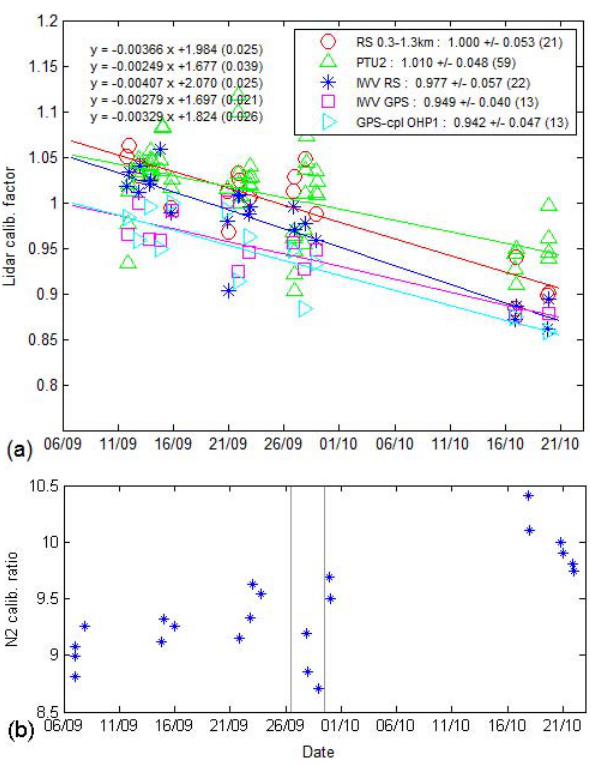
Fig. 4. Time series of (a) lidar calibration factors for the IGN- LATMOS lidar, determined with the four methods described in Sect. 3.1, (b) ratio of measurements in the H 2 O/N 2 channels with a common N 2